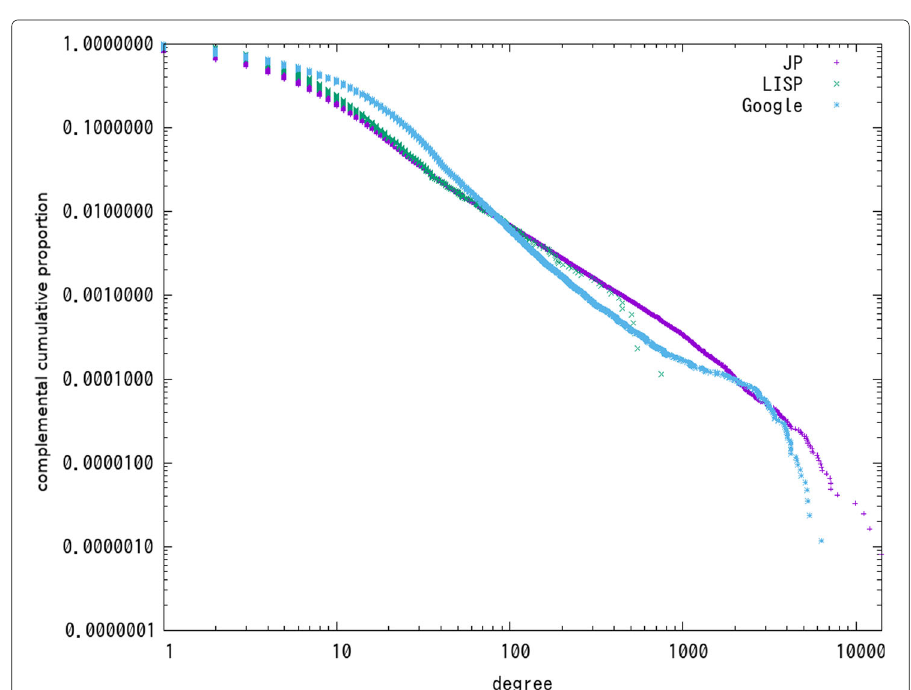
Fig. 3 Degree distribution of Japanese production network (JP) and emacs24 lisp network (LISP). Referenced distribution is for Google shown in Fig. 2